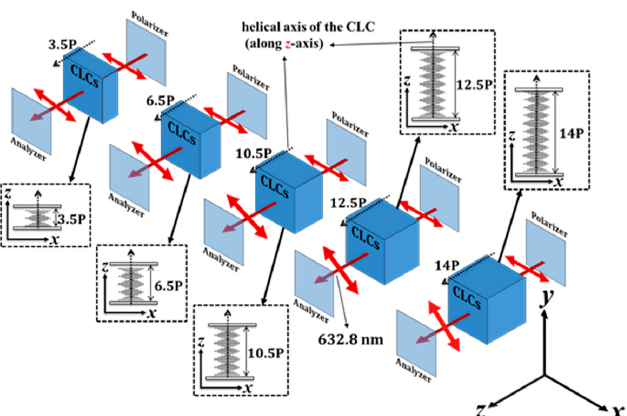
Figure 1. Experimental setup to investigate the rotation angle of LP (linearly polarized) light after passing through the CLC. The orientation of the linear-polarization of the transmitted beam is rotated in the x – y plane. P is the pitch of the five CLCs (cholesteric liquid crystals), whose helical axes are aligned along the z -axis. The five inserts in the dashed square represent the cross-sectional views of the five CLCs through the z – x plane.